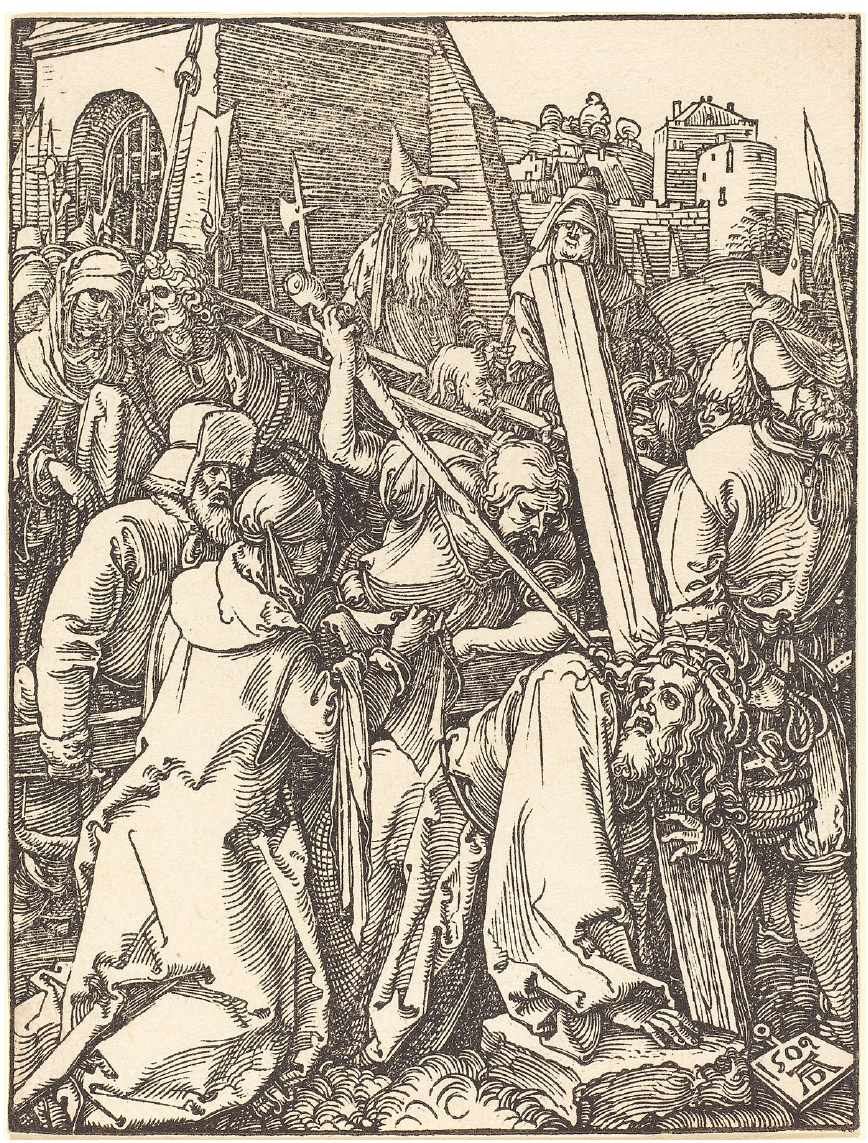
Figure 9. Albrecht Dürer, Christ Carrying the Cross from Small Woodcut Passion, 1511.